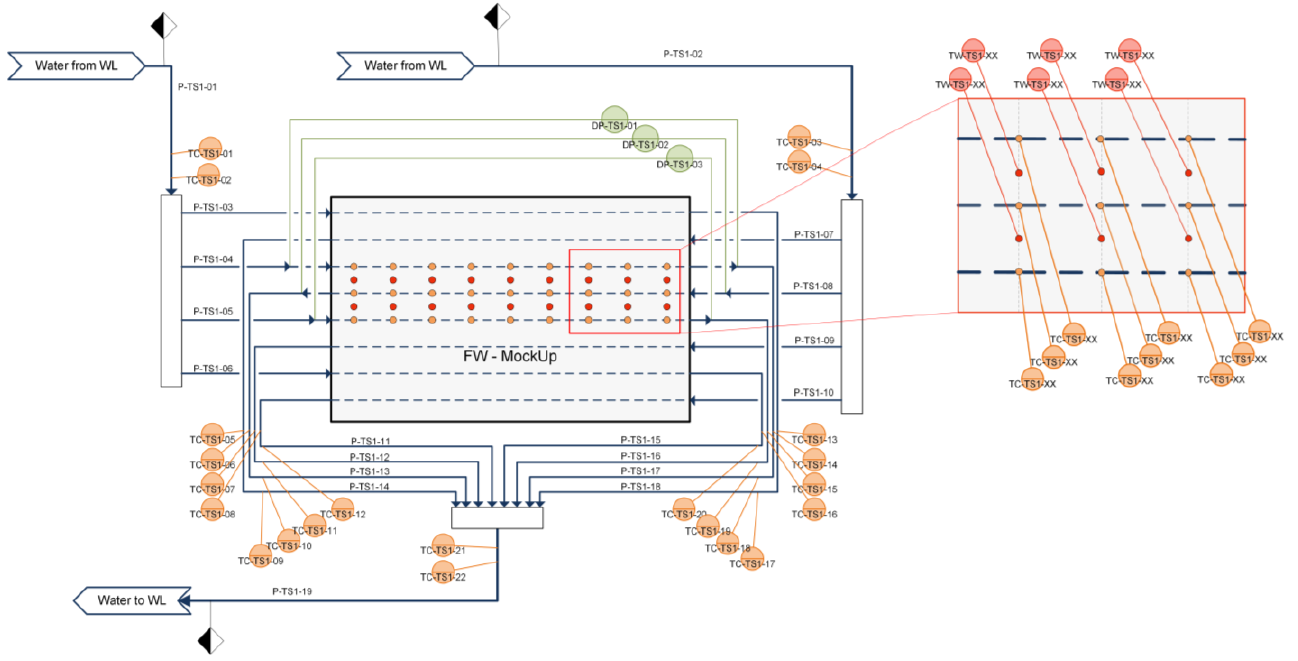
Figure 3. Pipe-and-instrumentation Diagram of the FW – MU .